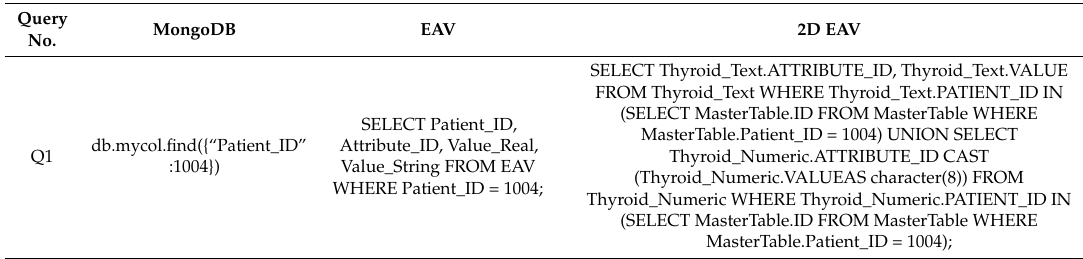
Table A3. Sample query